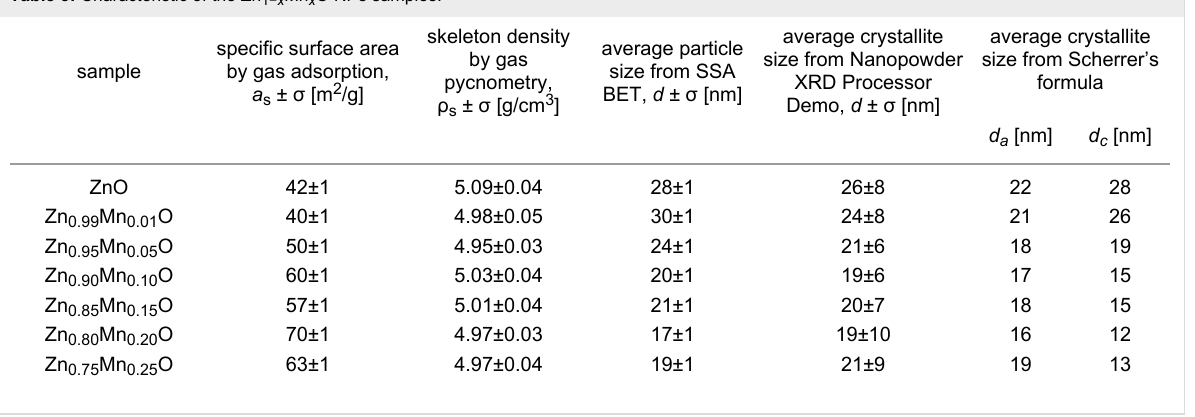
Table 5: Characteristic of the Zn 1 − x Mn x O NPs samples.